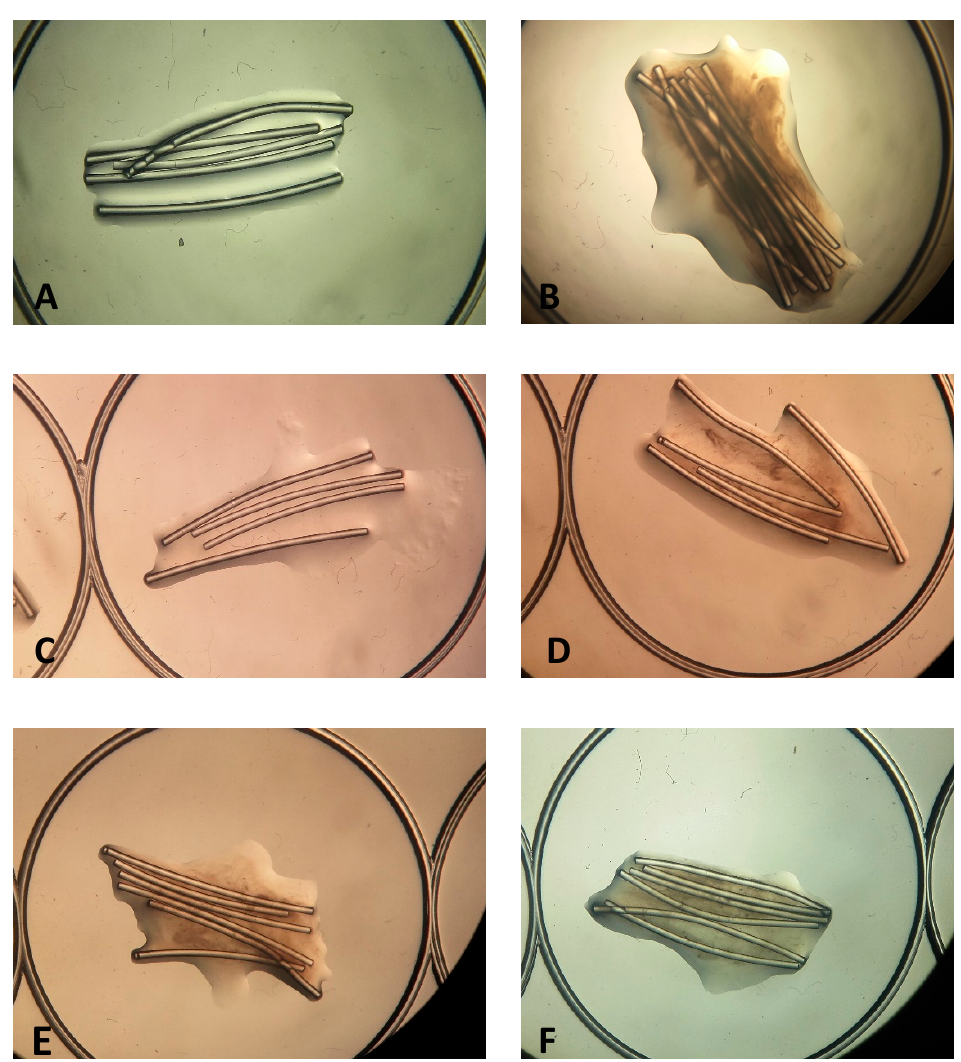
Figure 3. Biofilm formation in nylon fibers when in contact in different concentrations of the essential oil (EO) of oregano (observation in magnificent glass, 10× ampliation). ( A )—Negative control, ( B )—positive control, ( C )—well 2 (higher concentration of EO), ( D )—well 3, ( E )—well 5 and ( F )—well 6 (lower concentration of EO).